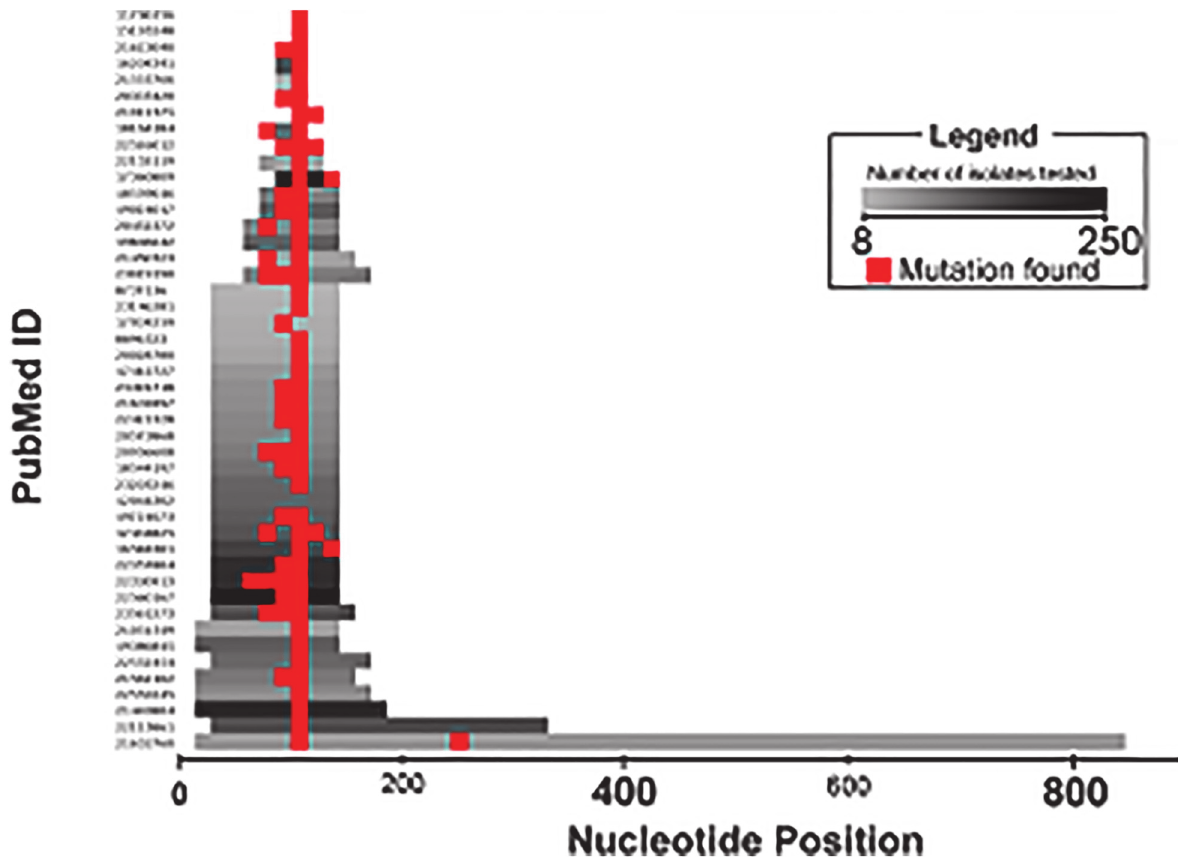
Fig 2. Heat map of Reviewed Studies that Evaluated gyrA Gene Mutations in Mtb . Heat map of individual papers indicating the number of isolates and the region of the gyrA gene studied. The number of isolates testes ranges from 8 (light grey) to 227 (black). Red indicates that a mutation has been